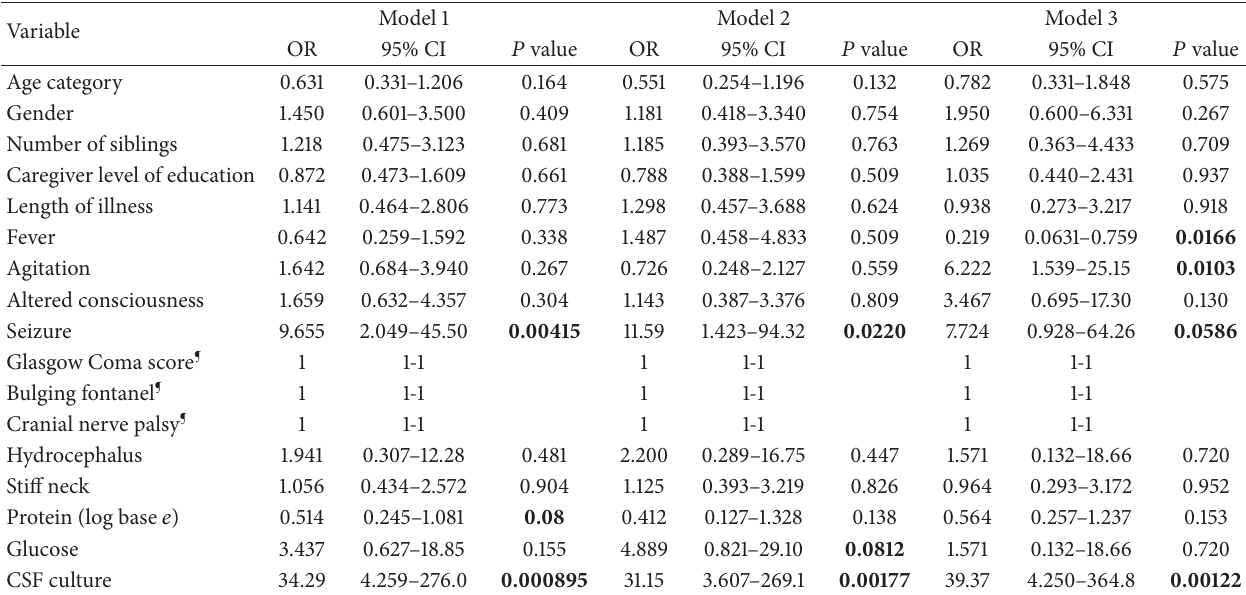
Table 4: Univariable ordinary logistic regression models.